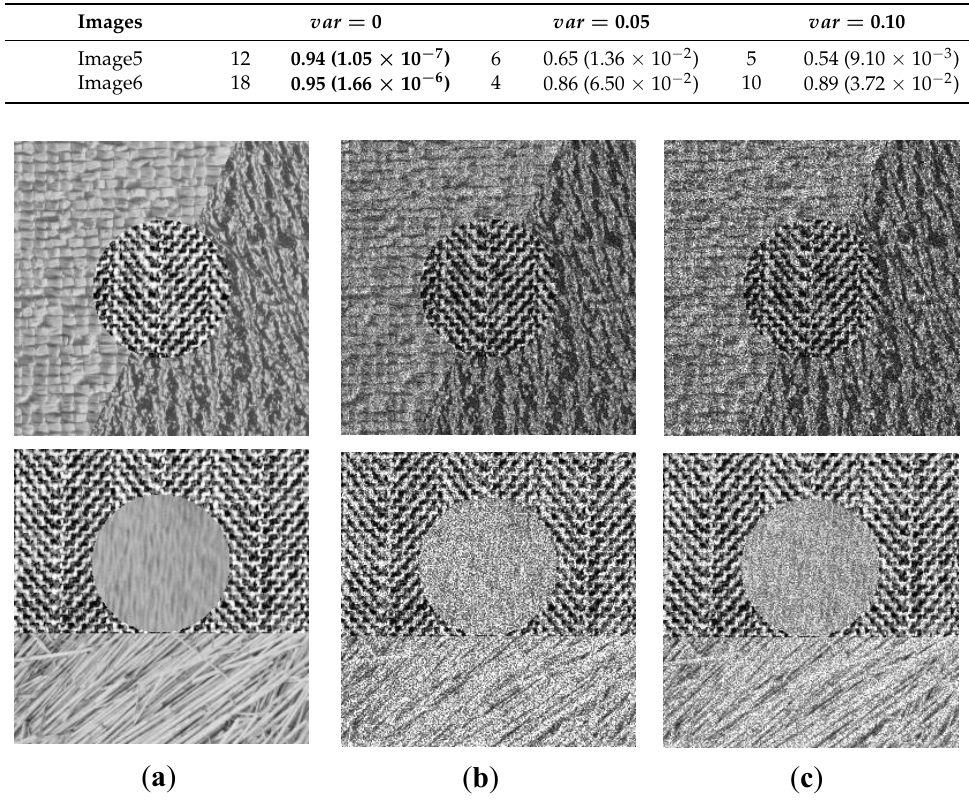
Figure 8. Texture images with speckle noise. ( a ) Original images; ( b ) var = 0.05; ( c ) var = 0.10.